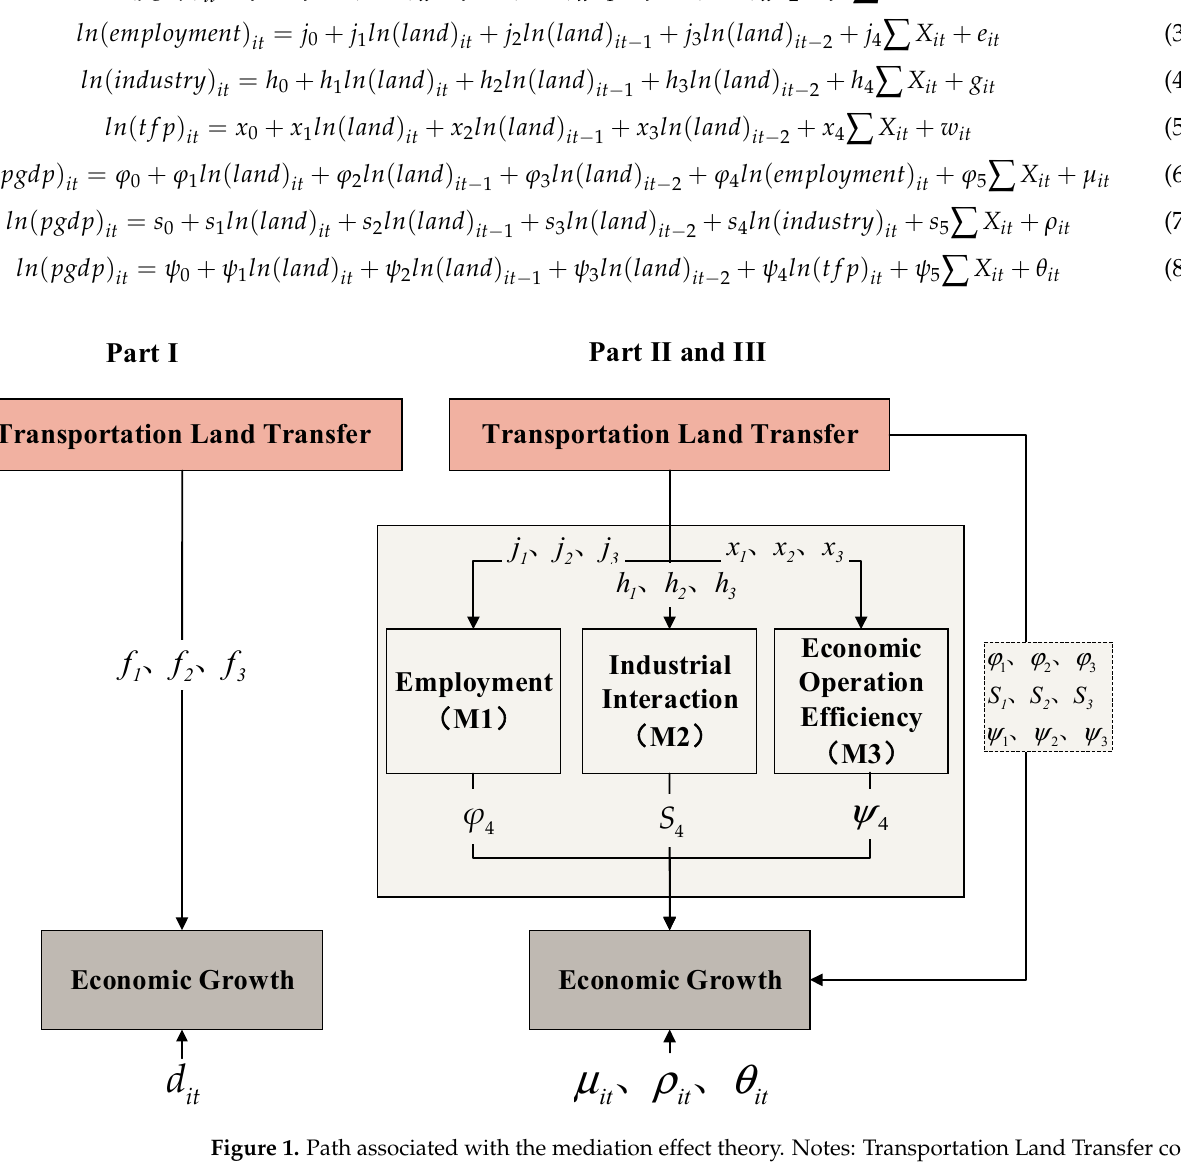
Figure 1. Path associated with the mediation effect theory. Notes: Transportation Land Transfer cor- responds to ln ( land ) it , ln ( land ) it − , ln ( land ) it − in Equations (2)–(8); Economic Growth corresponds to ln ( pgdp ) in Equations it